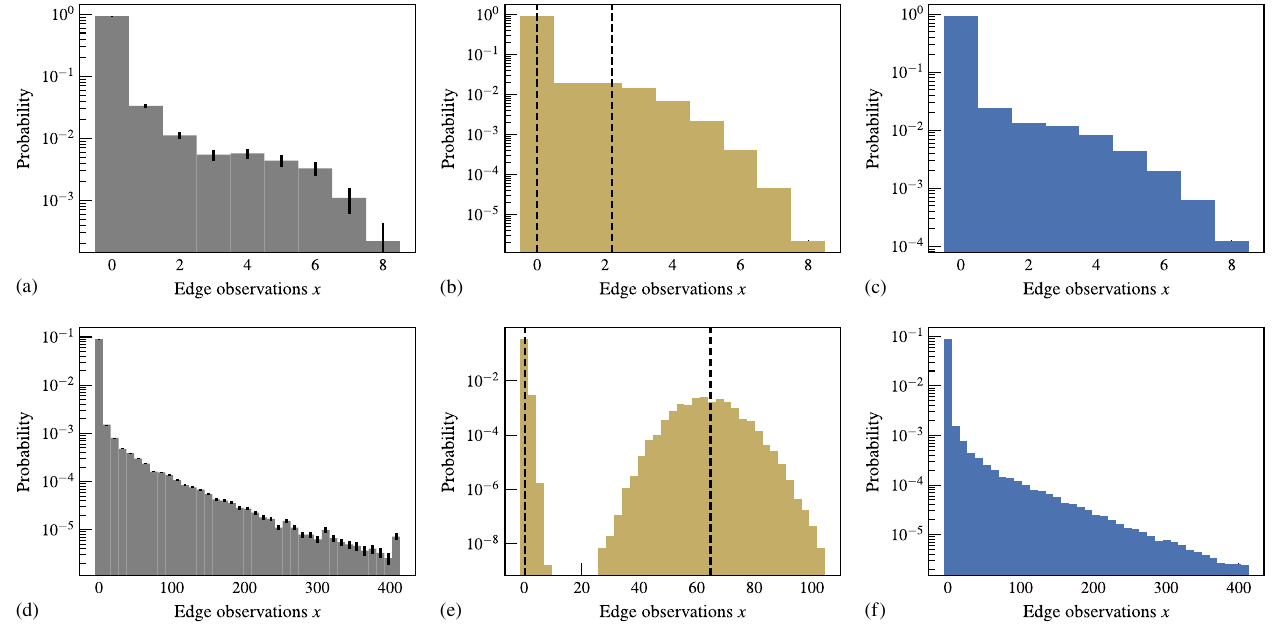
FIG. 13. Distribution of edge occurrences, x ij , for the reality mining (top row) and human connectome (bottom row) data sets. (a),(d) Empirical data. (b),(e) Generated from inferred parameters, according to the uniform model. (c),(f) Generated from inferred parameters, according to the nonuniform